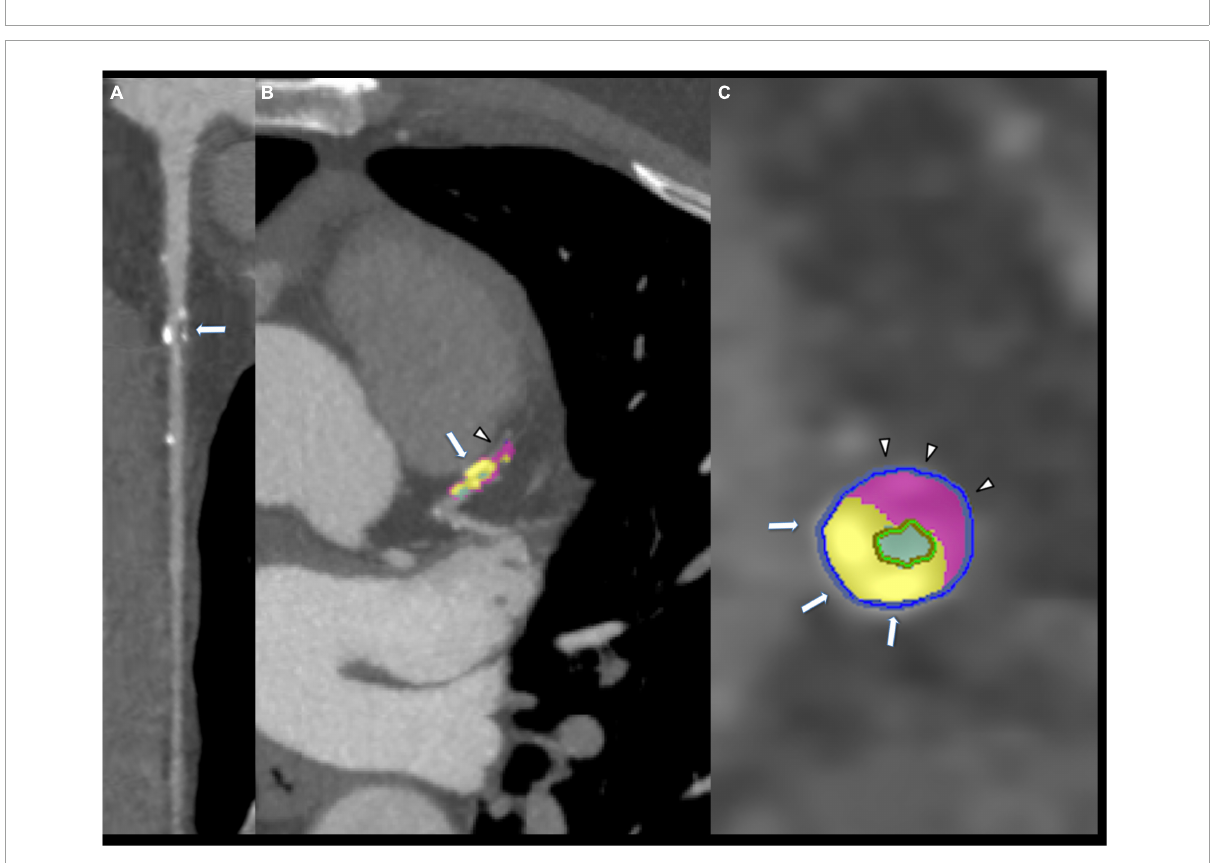
FIGURE2 Eighty-five years old male showing mixed coronary plaque on proximal left anterior descending artery (arrow, A ). Composition of plaque was composed by calcium (arrow, B,C ) and fibrofatty portion (arrowhead B,C